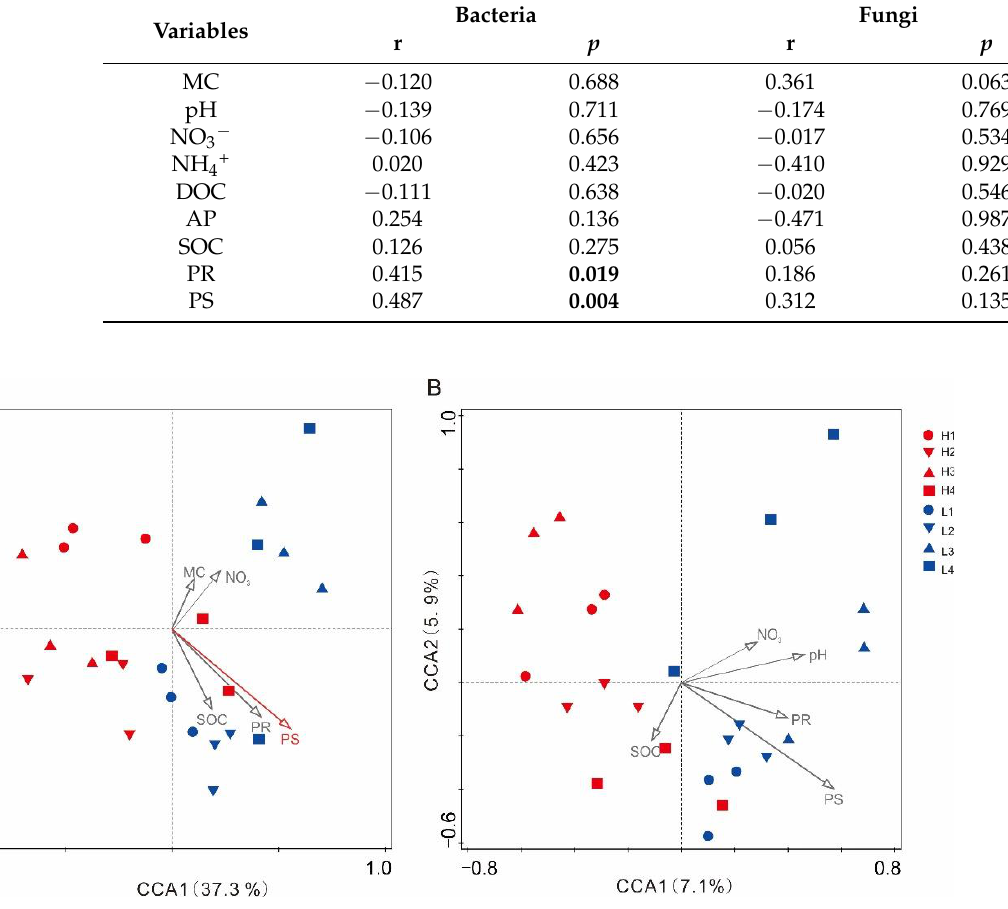
Figure 3. Non-metric multidimensional scaling (NMDS) of soil microbial communities based on pairwise UniFrac distance matrices. ( A ) Bacteria and ( B ) fungi: The consistency of the new model was determined by the stress value with the original data. Non-parametric ANOSIM (analysis of Table 5. Mantel test results for the correlation between microbial community composition and similarities) indicated significant differences between soil microbial community structure across environmental variables of the forests across elevations on Wuyi Mountain. Bold values indicate elevations on Wuyi Mountain. L1, L2, L3, and L4 correspond to forests at low elevations and H1, significant correlations ( p < 0.05). H2, H3, and H4 correspond to forests at high elevation levels, respectively.